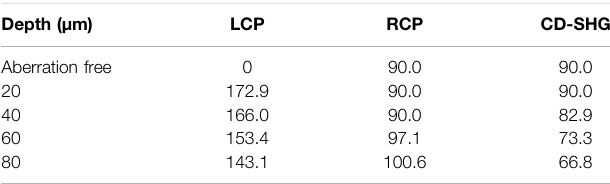
TABLE 1 | The azimuthal angle (degree) of the peak value (SHG) or valley value (CD-SHG) in Figure 2 . Depth ( μ m) LCP